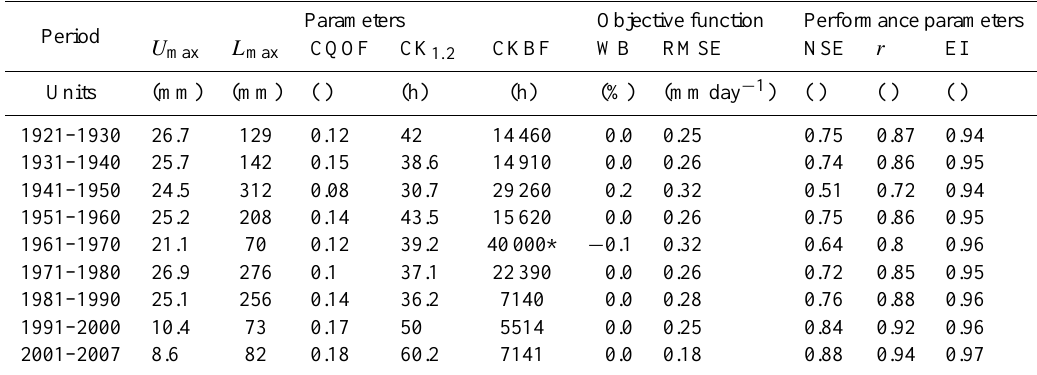
* The parameter has reached maximum value in the